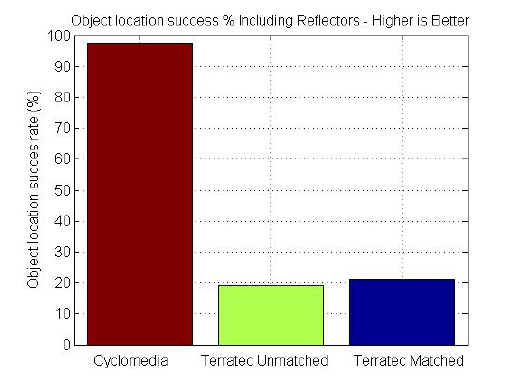
Figure 13: Cyclomedia and TerraTec solutions compared in terms of the percentage of the detected objects. In this plot, the reflective roadside markers are included into the data sets.